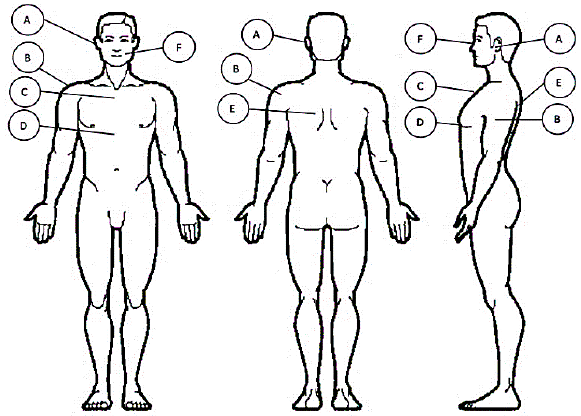
Figure 3. Sensor placement. ( A ) Ear channel for aural temperature measurement via the Cosinuss One, ( B ) upper arm where skin temperature and heat flux are measured with the gSKIN patch, ( C ) middle upper chest where skin temperature and heat flux are measured with the gSKIN patch, ( D ) lower chest where heart rate is measured with the Polar H7, ( E ) Scapula where skin temperature is measured with the shimmer, ( F ) mouth and nose where metabolic rate is measured via the MetaMAX-3B spiroergometer